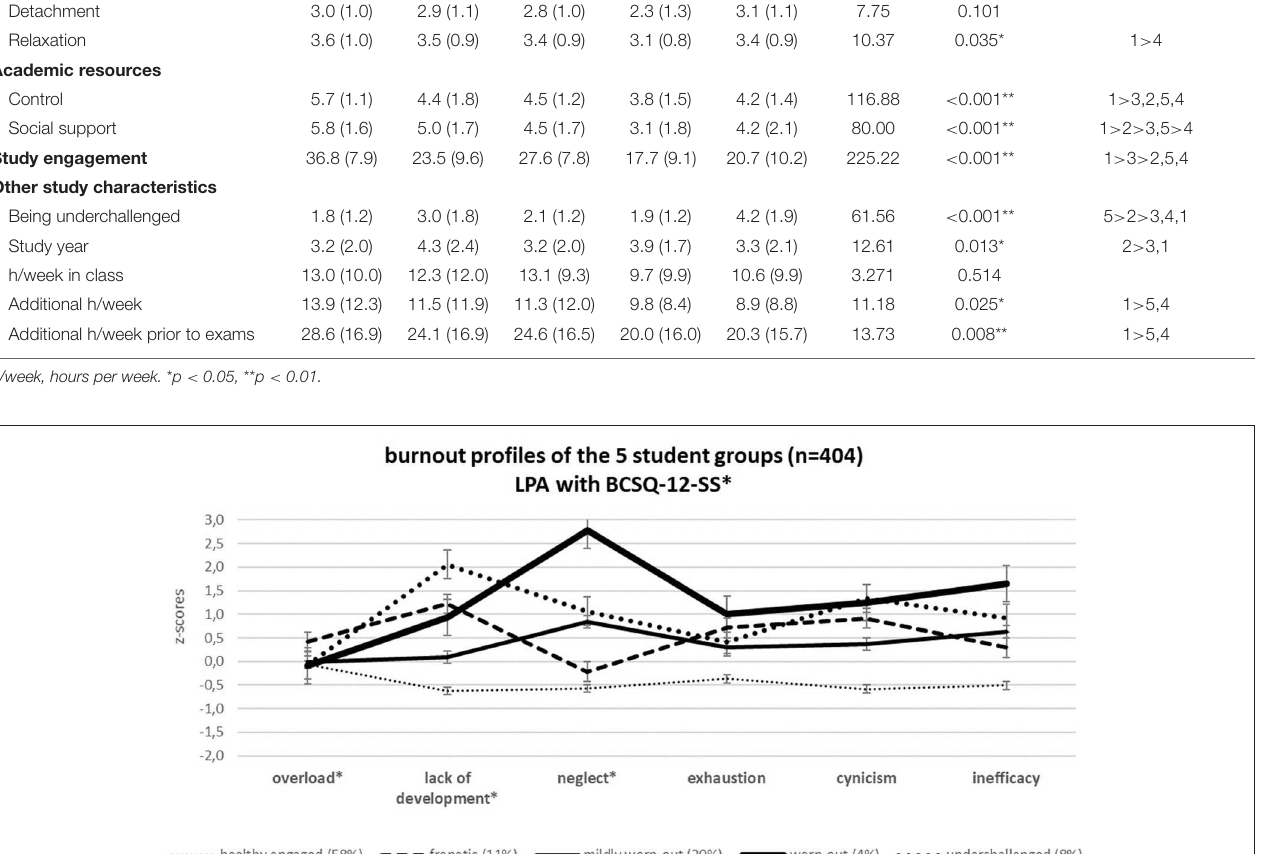
or burnout symptoms (MBI-SS). Frenetic students (13%) scored significantly higher on overload in the subsample; the other profile characteristics did not meaningfully differ from the entire sample. High exhaustion and high cynicism were again the most pronounced burnout symptoms in this student group. Mildly worn-out students (27%) had moderate to high scores on